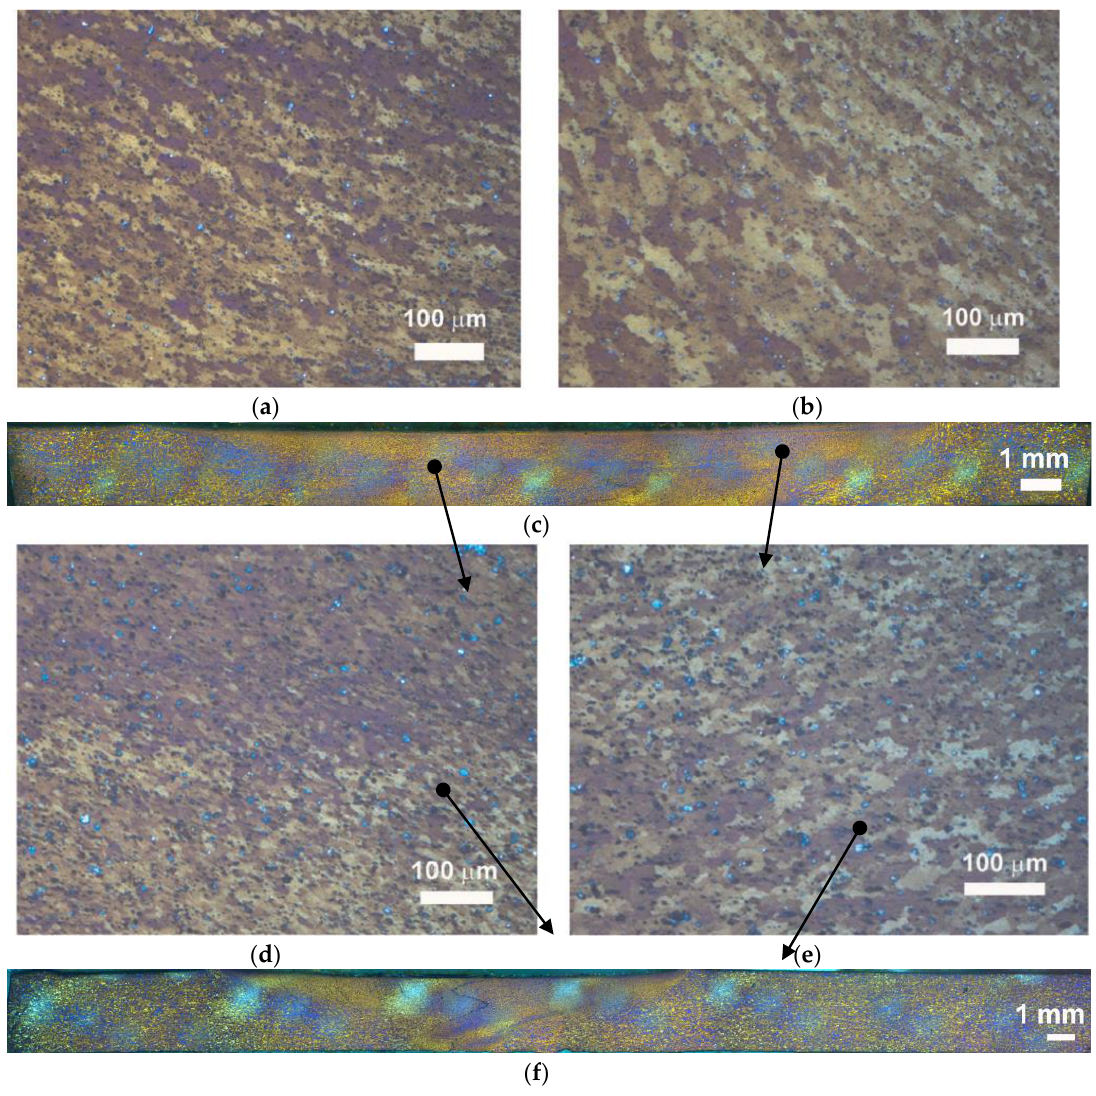
Figure 7. Polarized optical micrographs (POM) of the microstructure in the different zones of the welded joints in AA6082 obtained under different process methodology: ( a ) nugget zone (NZ) and ( b ) thermomechanically affected zone (TMAZ) of DS-FSW joints obtained using pin–pinless configuration; ( c ) a POM montage showing the whole DS-FSW section from which the detailed POM ( a ) and ( b ) were taken; (d) NZ and (e) TMAZ of a conventional FSW joint using pin configuration; ( f ) a POM montage showing the whole conventional FSW section from which the detailed POM ( d ) and ( e ) were taken. (v = 1200 r/min; v = 100 mm/min)